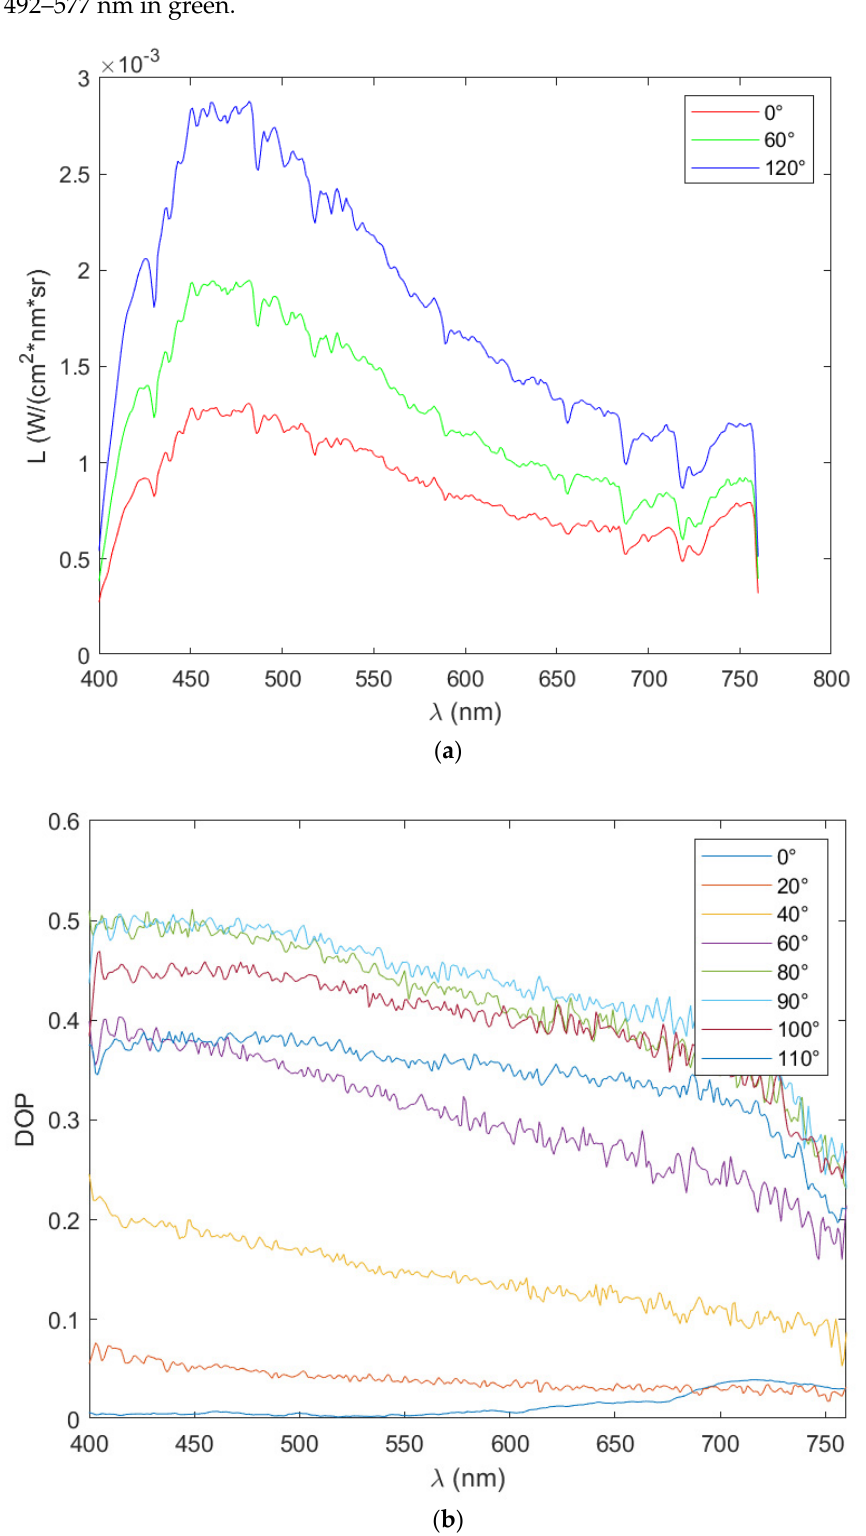
Figure 7. Measurement of polarization characteristics of the solar spectrum. ( a ) Solar spectral curve measured by the PSR-1100 spectrometer. ( b ) Spectral DOLP changing from facing the sun to 90 degrees away from the